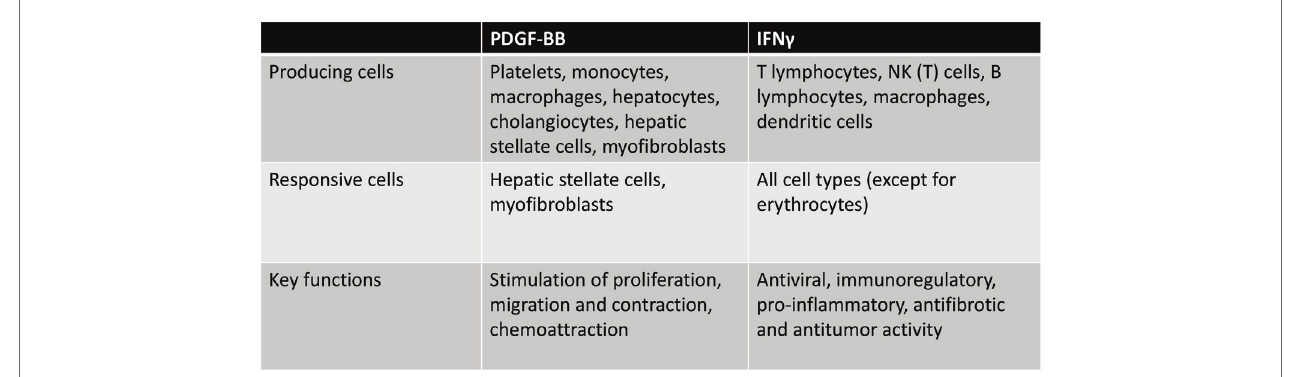
FiGURe 1 | Overview of PDGF-BB and iFN γ -producing cells and cells that respond to these mediators of fibrogenesis, illustrating the versatility of both mediators